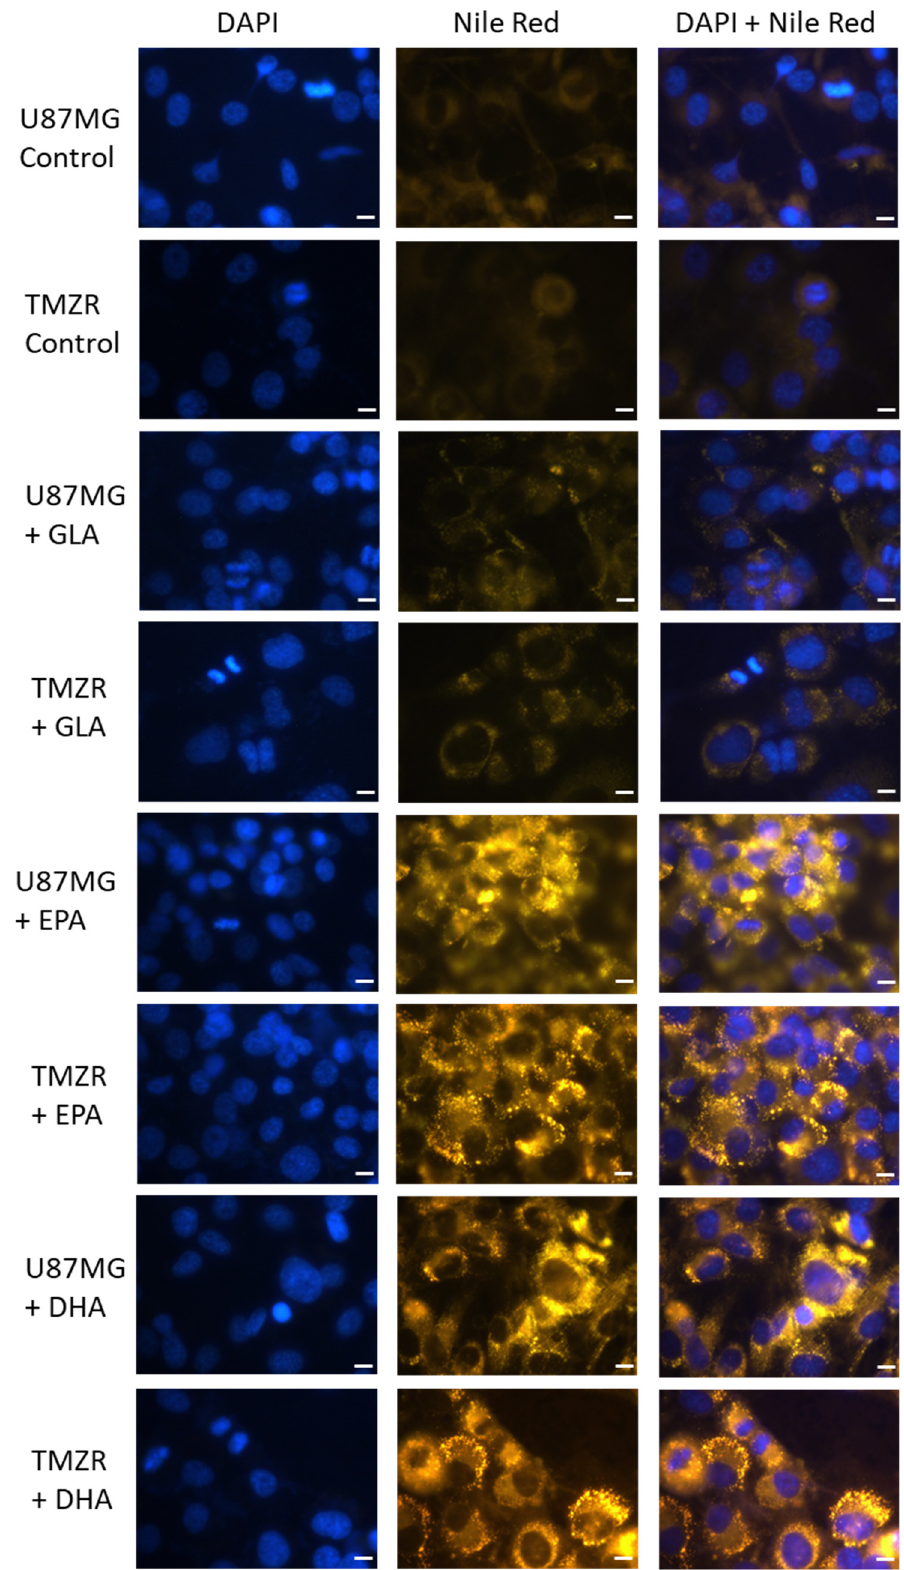
Figure 8. Effects of gamma-linolenic acid (GLA), eicosapentaenoic acid (EPA), and docosahexaenoic acid (DHA) on Nile Red staining of U87MG and TMZR cells. DAPI staining in blue, Nile Red in yellow. The control cells were exposed to a fatty-acid-free albumin vehicle at the same concentration as the fatty-acid-treated cells. Scale bar = 10 μ m.